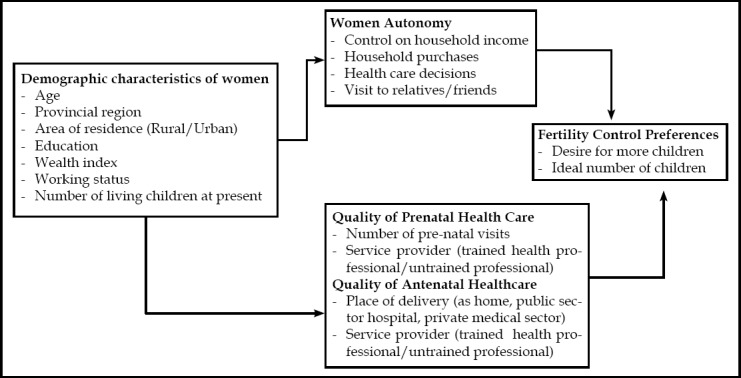
Conceptual Model.